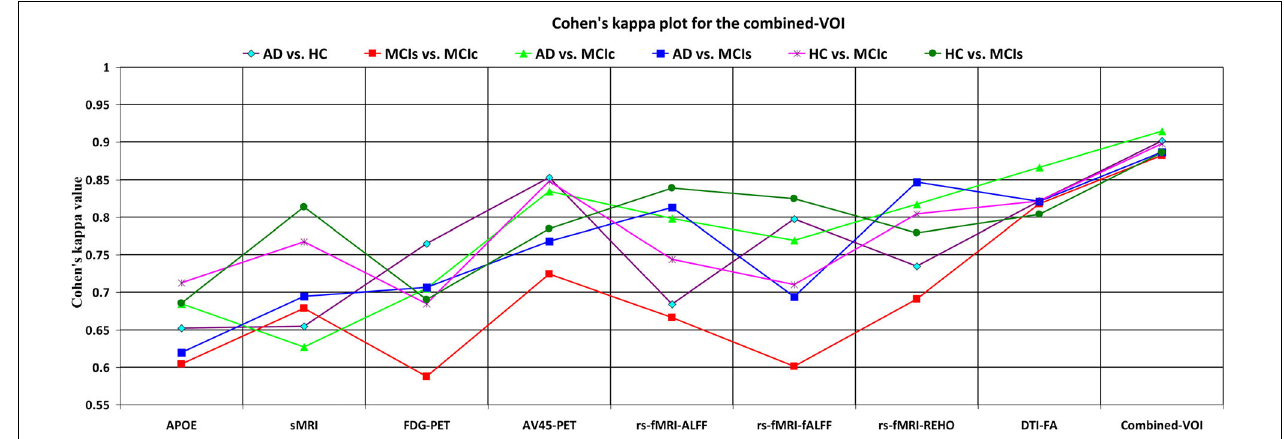
FIGURE 6 | Cohen’s kappa plot for AD vs. HC, MCIs vs. MCIc, AD vs. MCIs, AD vs. MCIc, HC vs. MCIs, and HC vs. MCIc are grouped using voxel-wise analysis. The above graph clearly shows the benefit of the combined-VOI modality over any single modality.